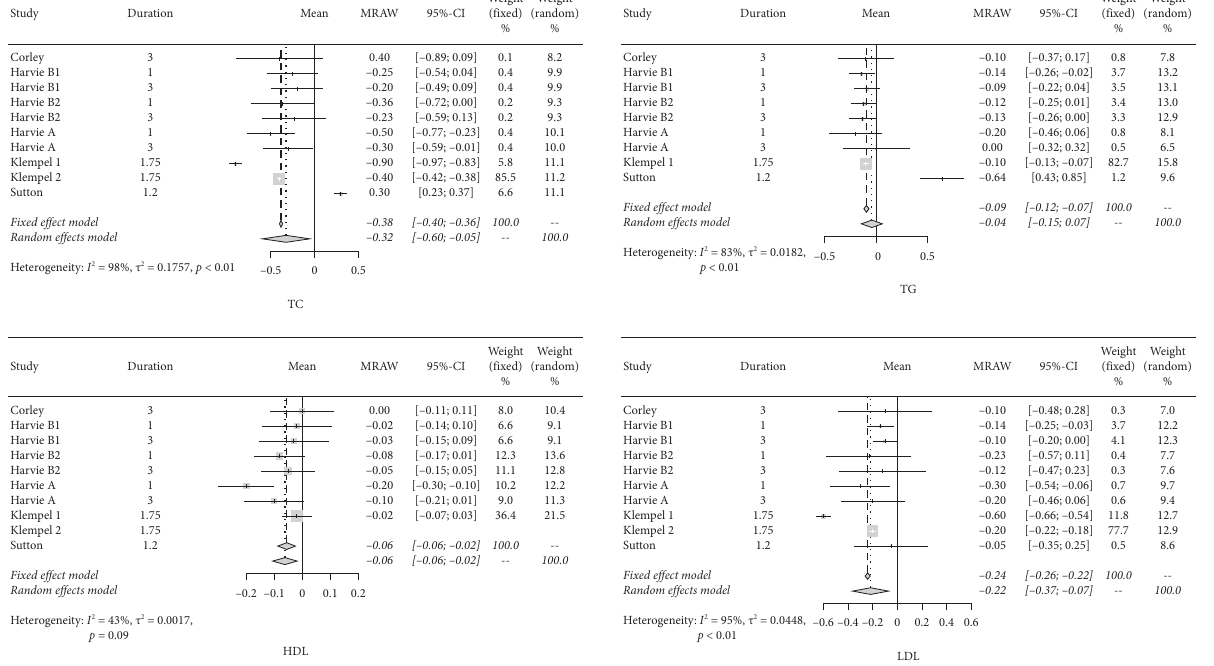
Figure 4: Forest plots for TC, TG, LDL, and HDL.